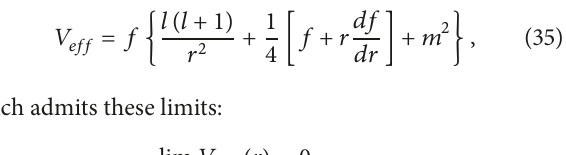
Figure 1: Effective potential versus tortoise coordinate graph for various orbital quantum